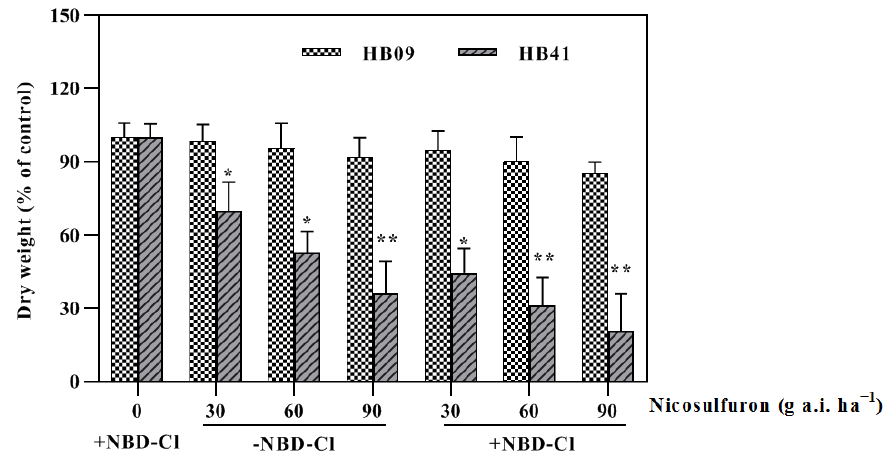
Figure 1. Effects of GST inhibitions (NBD-Cl) on maize growth response to nicosulfuron 21 DAT. The error bars represent the standard deviation (S.D.) of the mean of three independent replicates. Compared to the control group, statistically significant differences were referenced as * p < 0.05 and ** p < 0.01 by the t -test.